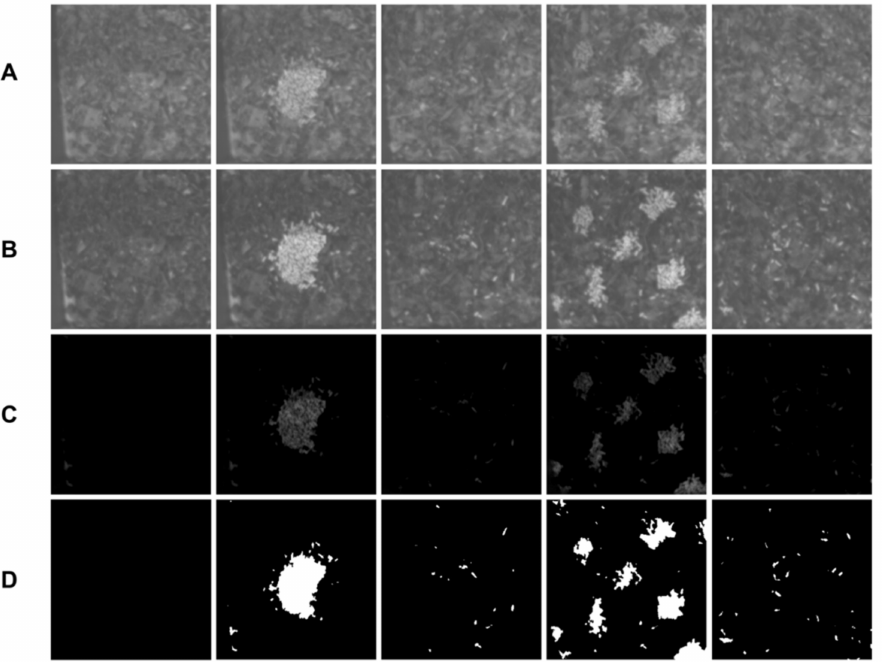
Figure 4. Fixed TMR images (from green and mixed fodder) in different mixing states: A—images at 672 nm spectral slice, B—images at 554 nm spectral slice, C—subtraction result, D—binarized images, (first column—images without mixed fodder).